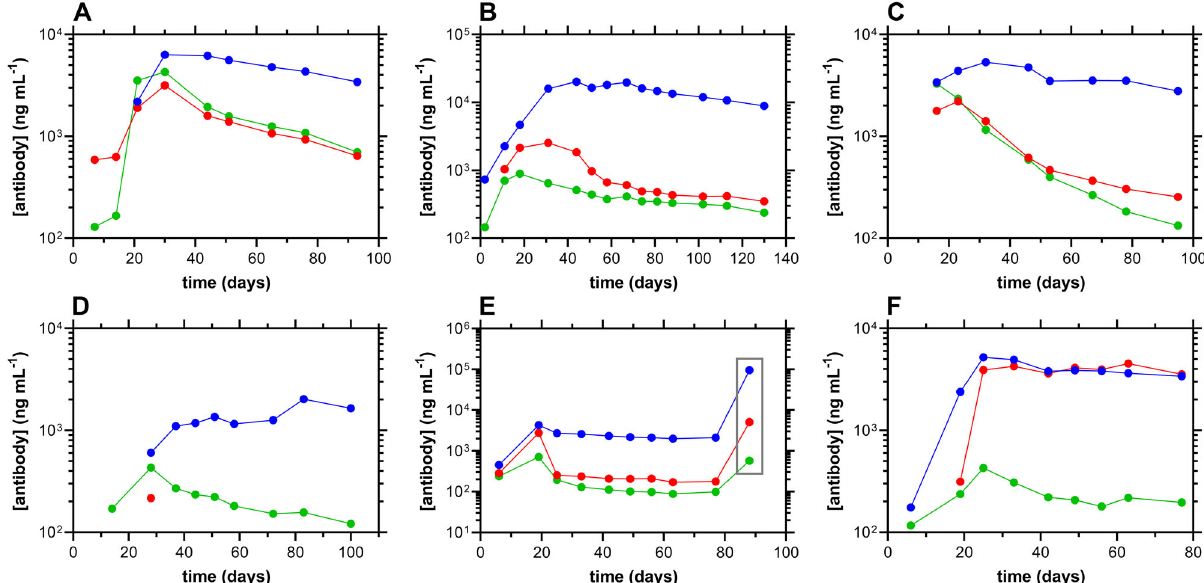
Fig. 6 Longitudinal antibody responses to SARS-CoV-2 in serum samples from six study participants, normalized temporally to the fi rst day of positivity by RT-qPCR. Blue, IgG; red, IgA; green, IgM. A subject 2; B subject 21; C subject 38; D subject 48; E subject 83, with gray box identifying timepoint post-immunization with Ad26.COV2.S vaccine (Research name: JNJ-78436735, Janssen Pharmaceutical Companies, also known as the Johnson and Johnson vaccine); F subject decay model. Due to the stability of the IgG serum concentrations over the ca . 90-day window of analysis, only t 1/2 values for IgA and IgM could be calculated for fi ve individuals: t 1/2 (IgA): median, 8.8 d; min, 2.3 d; max, 32.1 d; t 1/2 (IgM): median, 10.4 d; min, 1.1 d; max, 10.7 d. When the IgA and IgM t 1/2 values were compared using a Wilcoxon matched-pairs signed rank test, the datasets were found not to be signi fi cantly different ( P > 0.9999). over the same time period only could be quanti fi ed for IgG, and these remained stable throughout (Fig. 7B; median [IgG], 162 ng mL − 1 ). Interestingly, the IgG measurement on Day 6